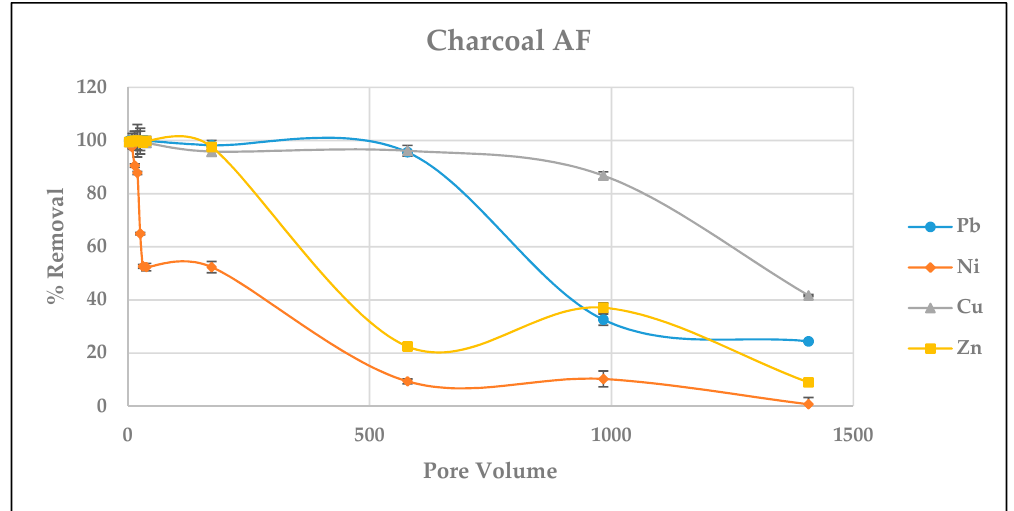
Figure 5. Percentage removal of the four metals by charcoal amended filters as a function of pore volume. AF stands for amended filter.